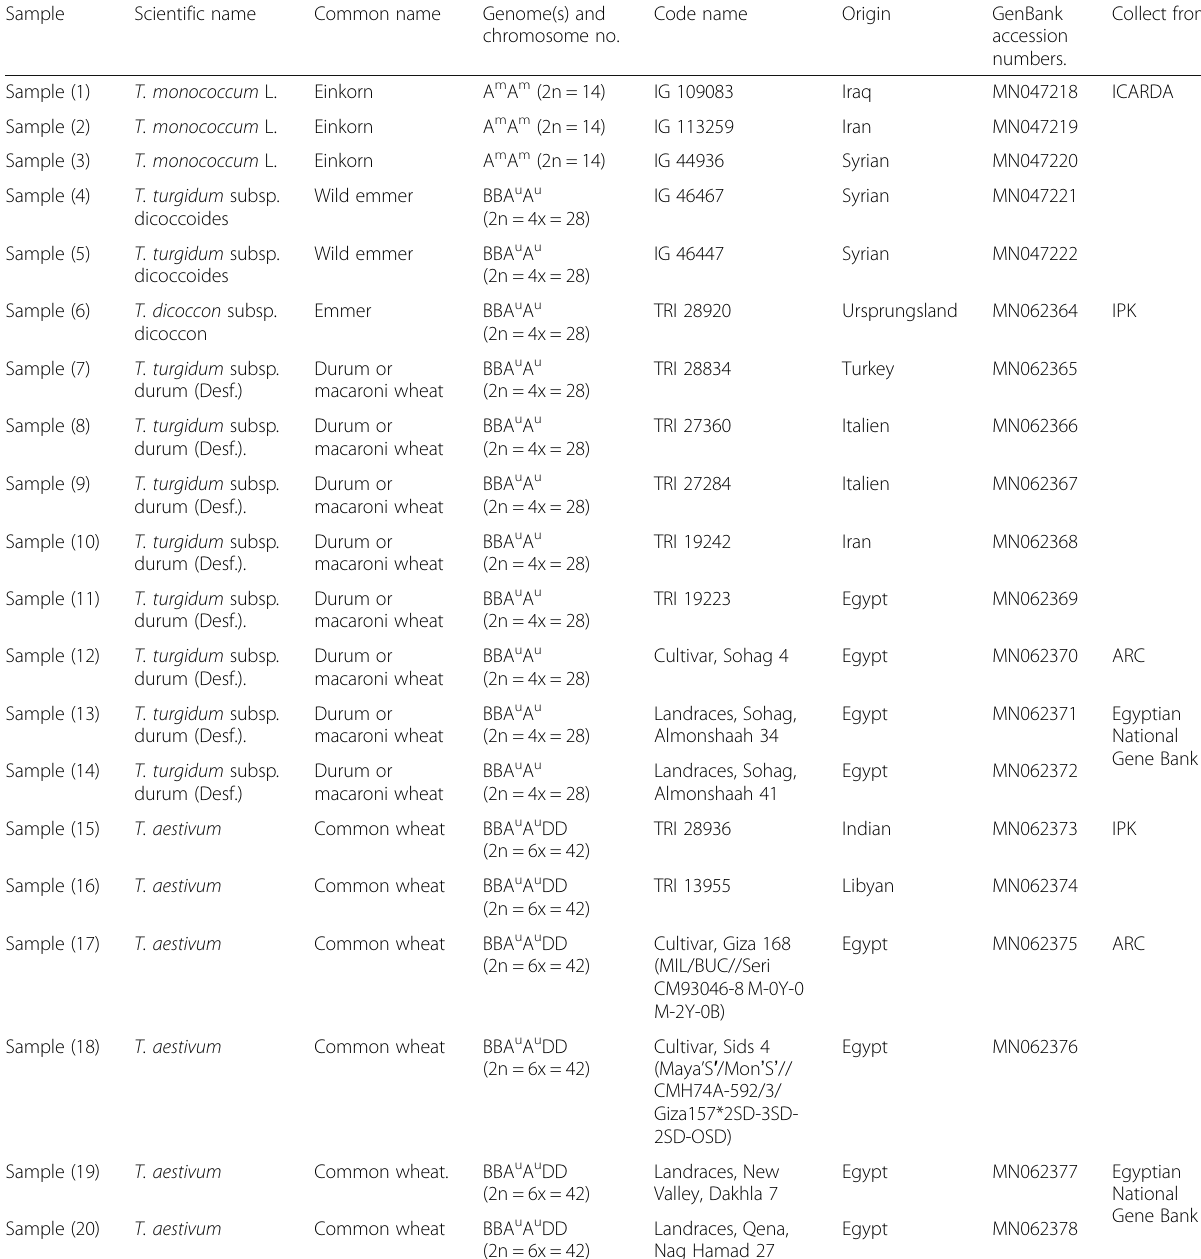
Table 1 The scientific and common name of 20 different Triticum species from a different country with code name and its